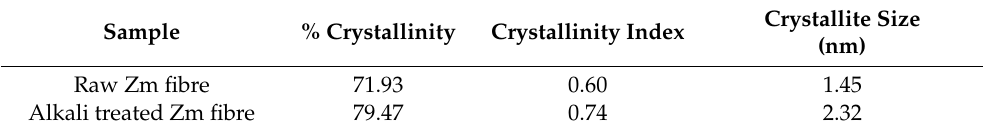
Table 3. Crystallographic information from p-XRD